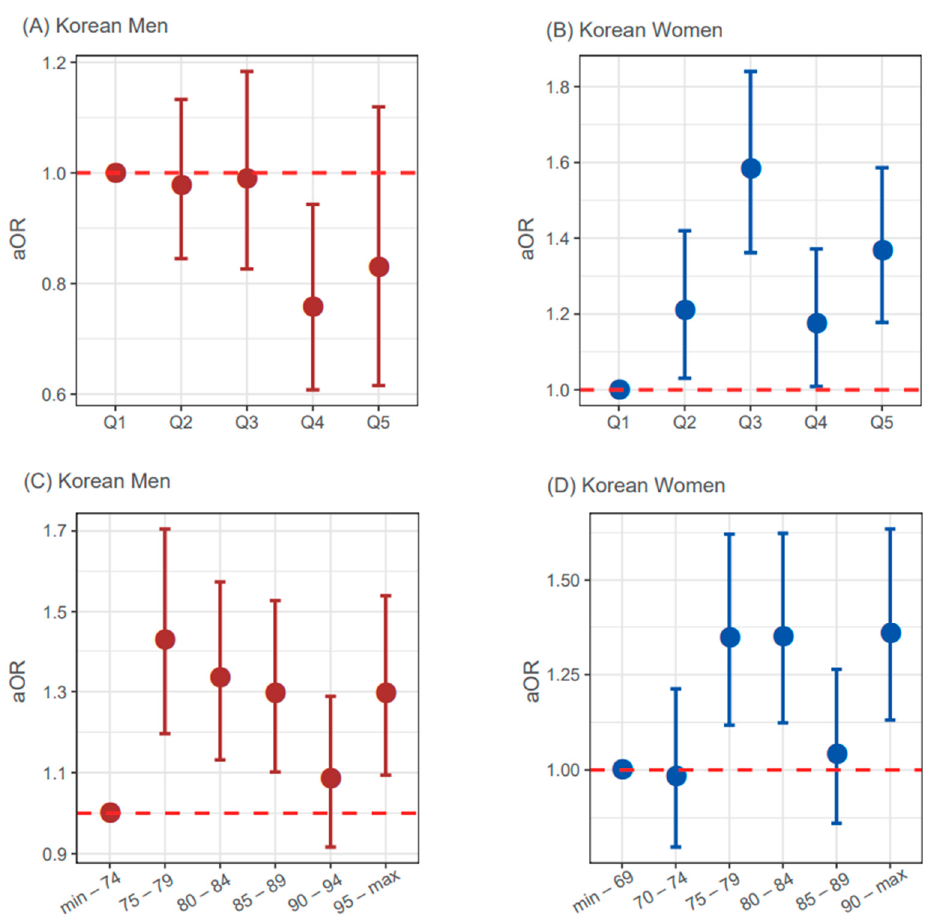
Figure 3. Sex-specific non-linear relationships between waist circumference and the risk for stroke. Adjusted ORs (aORs) were measured using the multivariate logistic regression including age, anti- hypertensive medication, diabetes, current smoking, systolic blood pressure, total cholesterol, and high-density lipoprotein cholesterol as covariates. The cut-offs of WC were determined based on quintile method ( A , B ) and empirical cut-offs ( C ), men: 75, 80, 85, 90, and 95 cm; ( D ), women: 70, 75, 80, 85, and 90